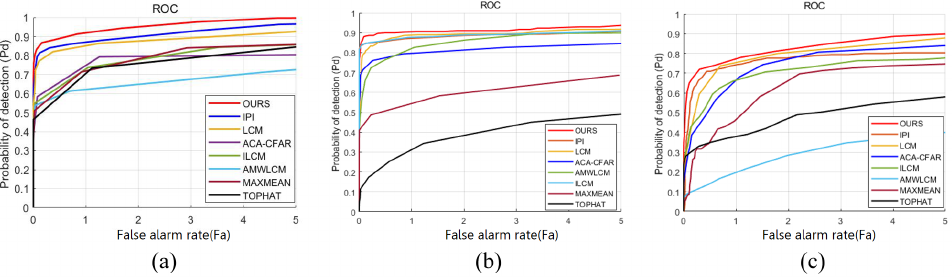
Figure 9. The ROC curves of eight algorithms for the three real image sequences. ( a ) Real Seq. 1, ( b ) Real Seq. 2, ( c ) Real Seq.